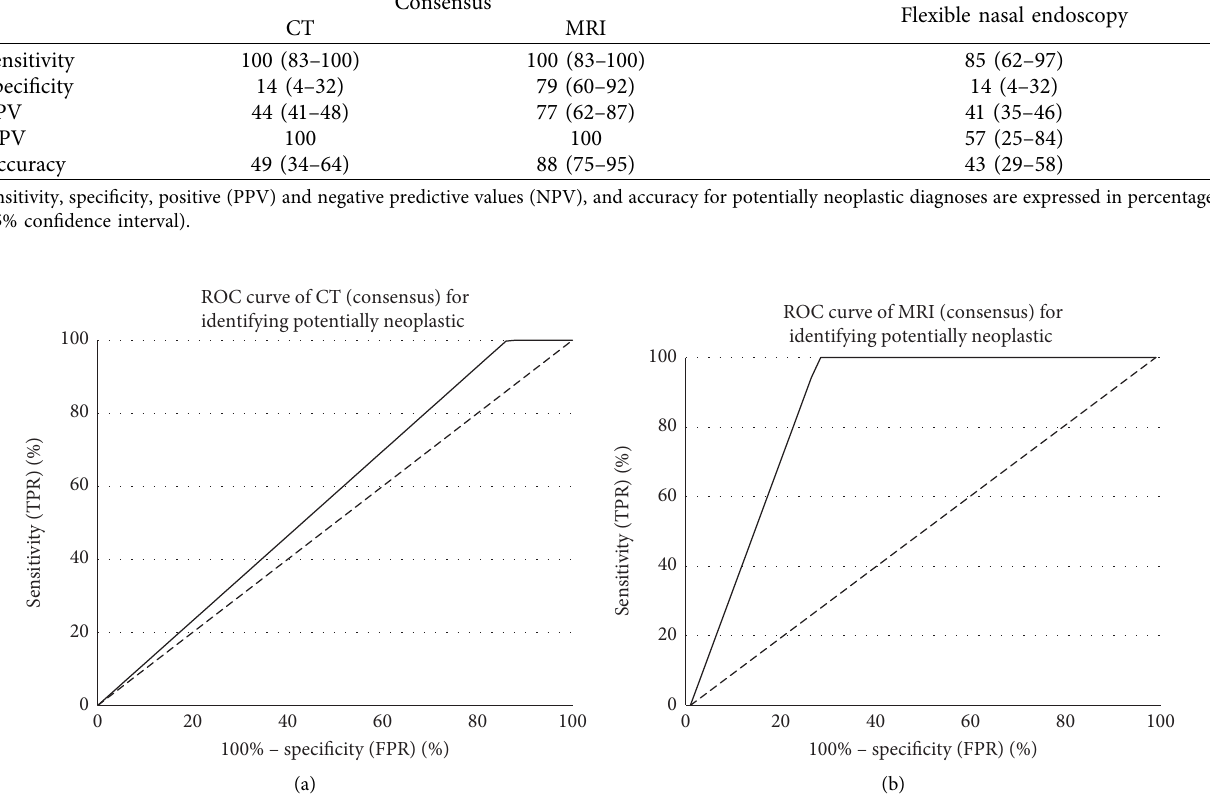
Figure 2: Receiver-operating-characteristic (ROC) curves for differentiating potentially neoplastic from infective/inflammatory causes of unilateral maxillary sinus opacification, for consensus radiological diagnoses: (a) on CTand (b) on MRI. X-axis: false positive rate (FPR), Y- axis: true positive rate (TPR).